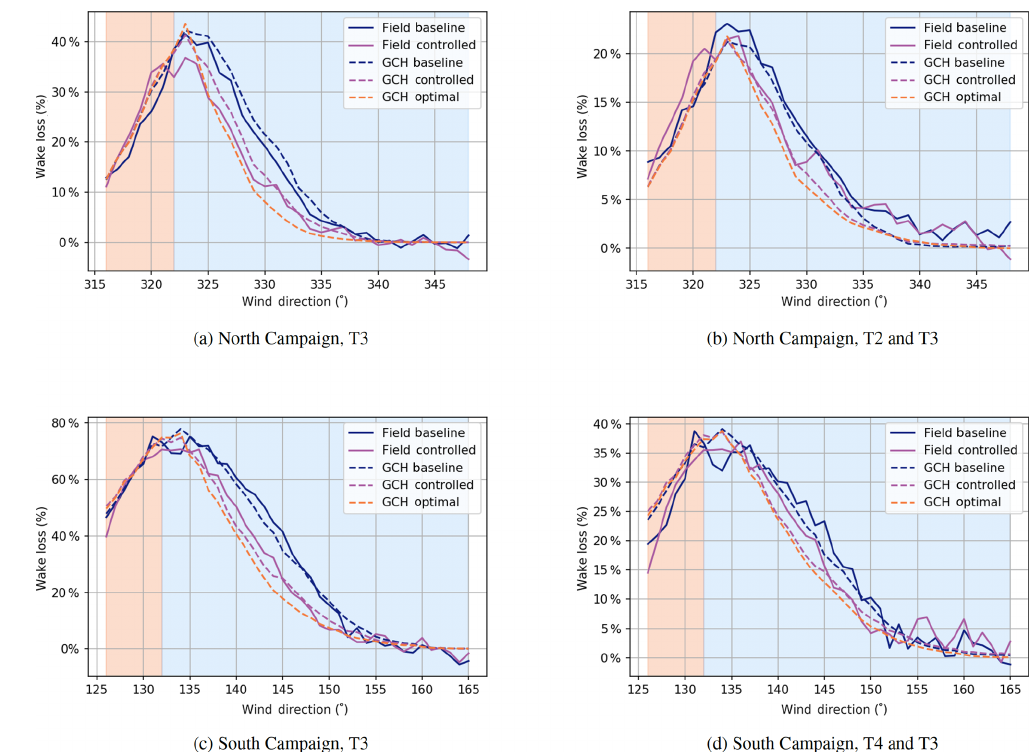
Figure 11. Wake losses computed per wind direction bin for the North and South Campaigns. The wake losses in panels (a, c) are computed for the downstream T3 only. In panels (b, d) , the total wakes losses of the combined upstream and downstream power for the respective campaign are computed. In both cases, the references are as before: T1 and T5 for the North Campaign and T1 for the South